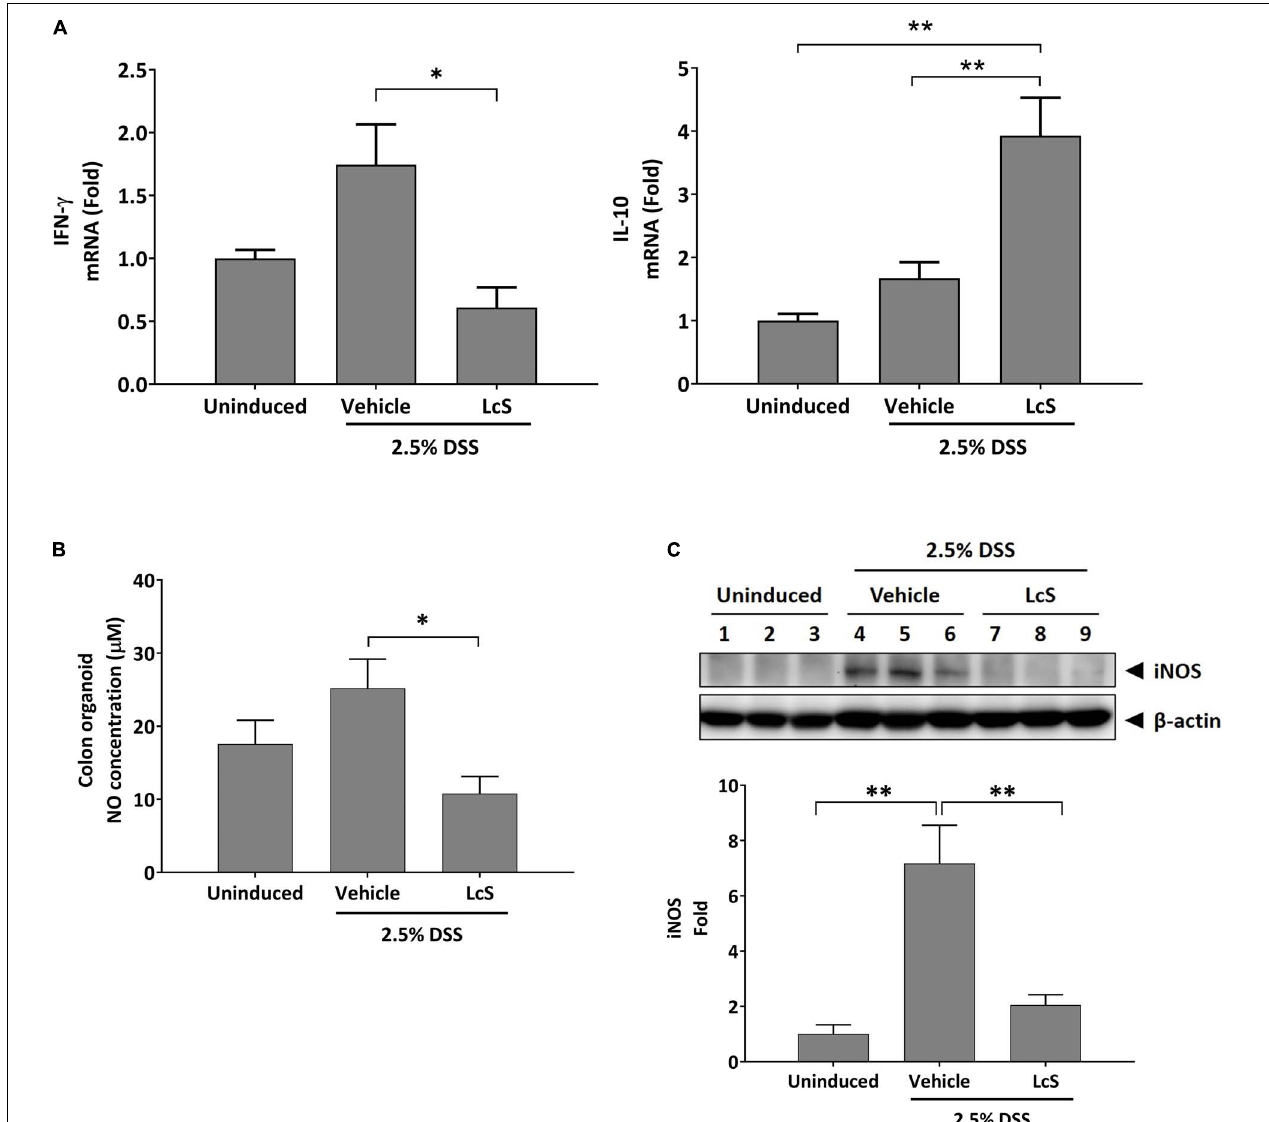
FIGURE 5 | LcS modulated inflammatory mediator production. Gene expression levels of (A) IFN- γ and IL-10 in mouse colons. Expression levels of the genes were normalized to uninduced mice. (B) NO production levels in mouse colon cultures. (C) Representative Western blot images of iNOS in mouse colons. Protein expression levels were normalized to uninduced mice. Data are expressed as mean ± SEM; ∗ p < 0.05, ∗∗ p <